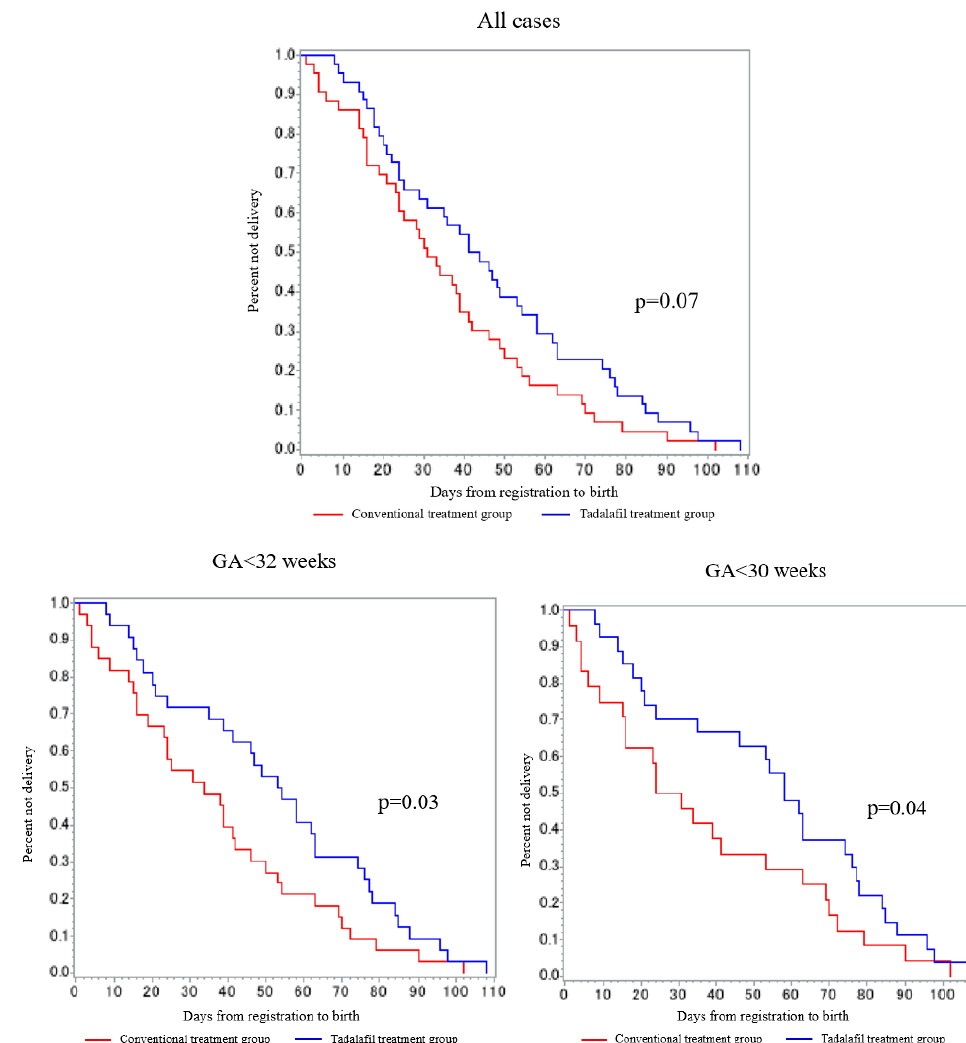
Figure 3. Prolongation of gestational weeks. Prolongation of GA was defined as days from the first day of protocol-defined treatment to birth. The figure above shows the prolongation of GA in Kaplan–Meier curves for each GA at treatment initiation (all cases, < 32 weeks, < 30 weeks), comparing binary data across two groups using the generalized Wilcoxon test.